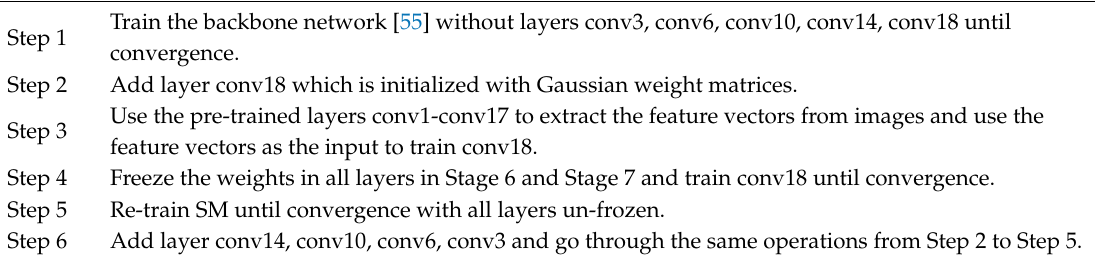
Algorithm 1 : Scheme of training